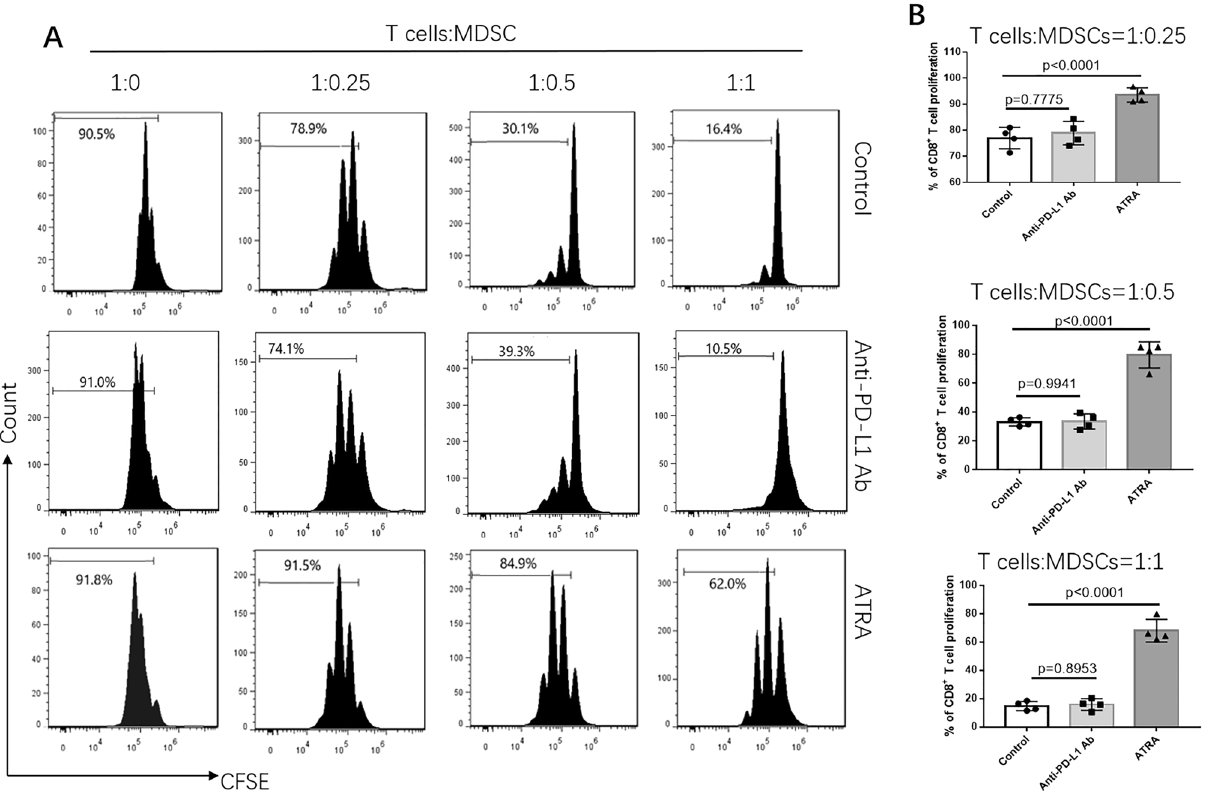
Figure 3. The role of anti-PD-L1 Ab or ATRA to relieve the suppression of T-cell proliferation by MDSCs. ( A ) Representative flow cytometric histograms from a T cell proliferation suppression assay. ( B ) Bar charts showing that MDSCs suppressed proliferation of CD8 + T cells in a dose-dependent manner (T: MDSC cell = 1:0.25, 1:0.5, 1:1). In the presence of anti-PD-L1 antibody (50 μg/mL), the decrease of MDSC-mediated suppression was limited. ATRA (2 μM) significantly reversed MDSCs-mediated suppression under different suppressive conditions. Data are representative of 4 separate experiments. Data are shown as mean ±